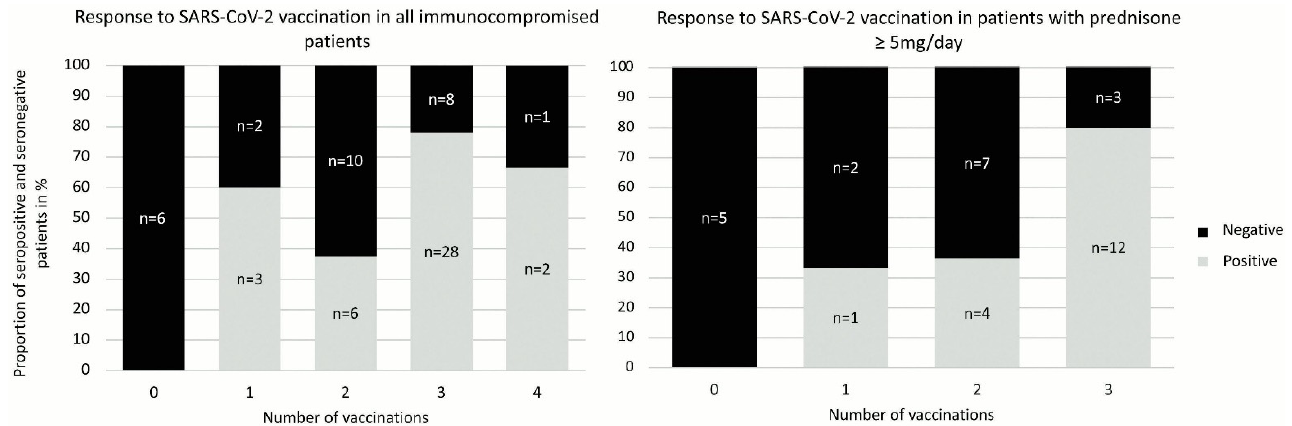
Figure 1. Seroconversion in immunocompromised patients in relation to the number of vaccinations. Only patients with known vaccination and serostatus were included in the figure.